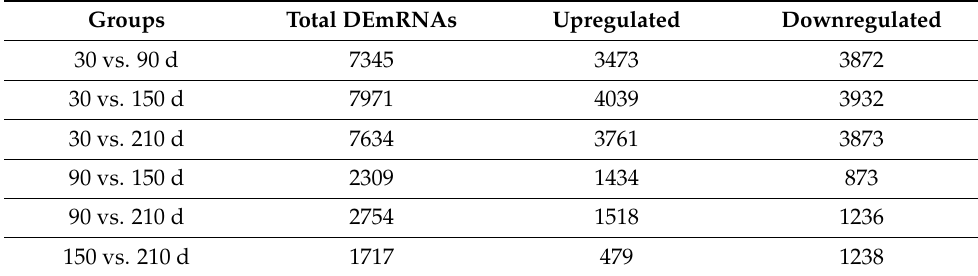
Table 4. Differential expression of mRNAs.